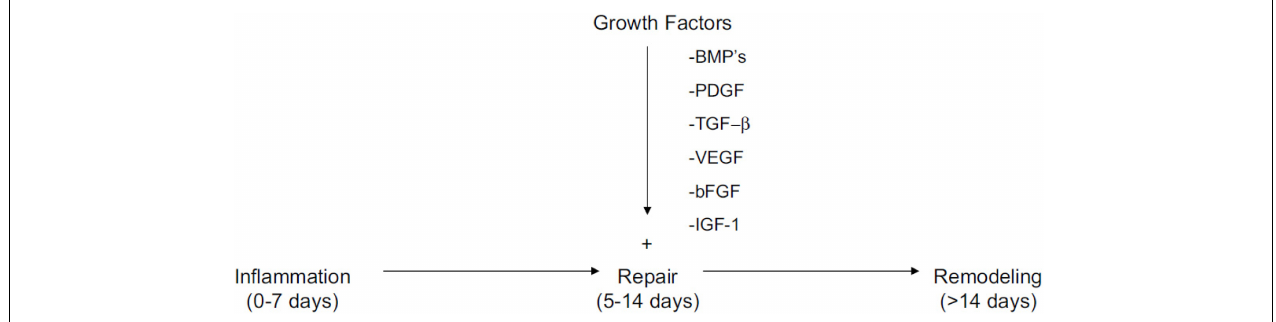
FIGURE 7 | Inflammation, repair, and remodeling stages are three main stages in rotator cuff repair. All kinds of growth factors play an important role in the repair process (Gulotta and Rodeo, 2009).